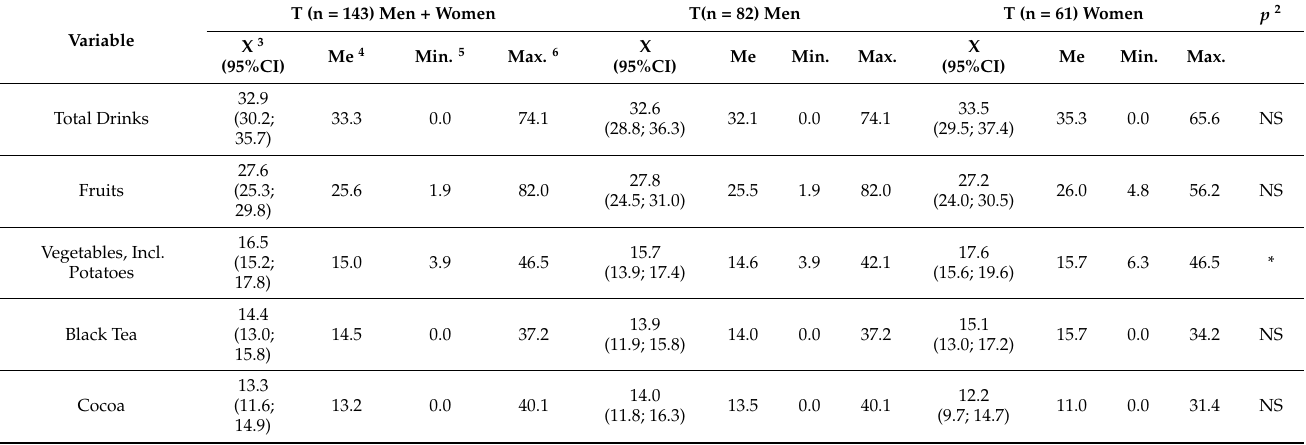
Table 2. The shares (%) of selected foods in the total antioxidant capacity (T-ORAC) of the daily diets in the study group. On average, four seasons 1